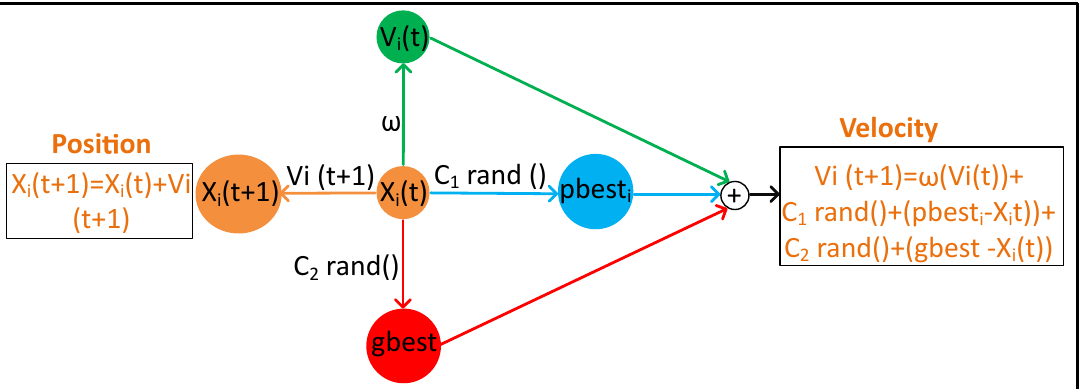
Figure 3. Graphical Representation of Personal Best and Global